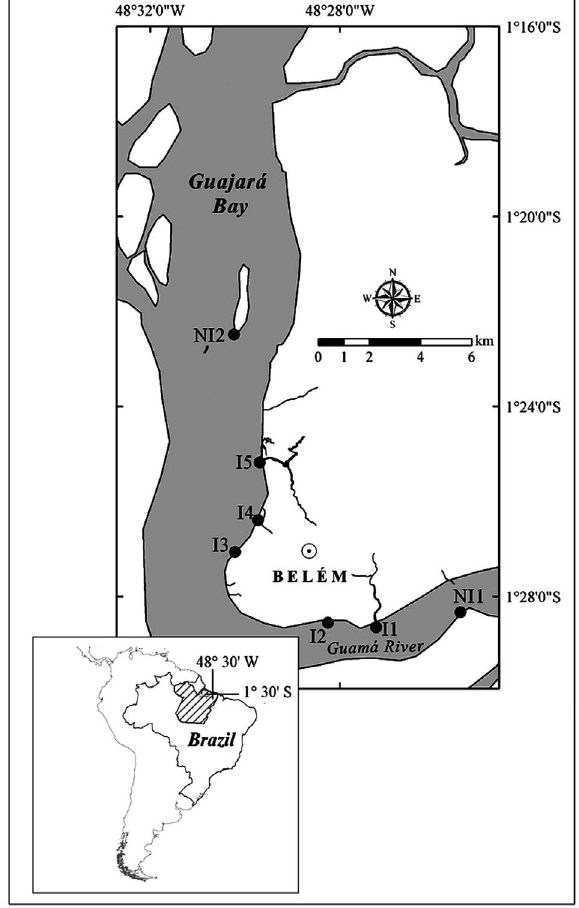
Fig . 1. – Study area in the Guajará Estuary showing the sampling